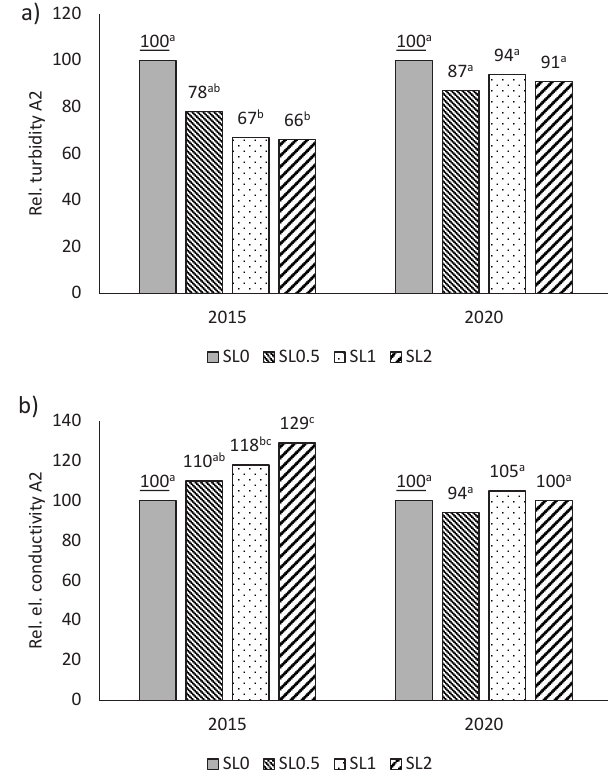
Fig. 4. (a) Relative turbidity and (b) relative electrical conductivity in leachate collected after a second simulated rainfall event on 2–5 mm aggregates of tilled soil collected one year (2015) and six years (2020) after structure liming at a rate of 4, 8 and 16 t ha -1 (SL0.5, SL1 and SL2, respectively), calculated as a mean for all trials based on statistical analyses of original data (absolute values) and expressed relative to values obtained for the unlimed control (SL0 = 100). Different letters on bars indicate significant differences between treatments ( p <